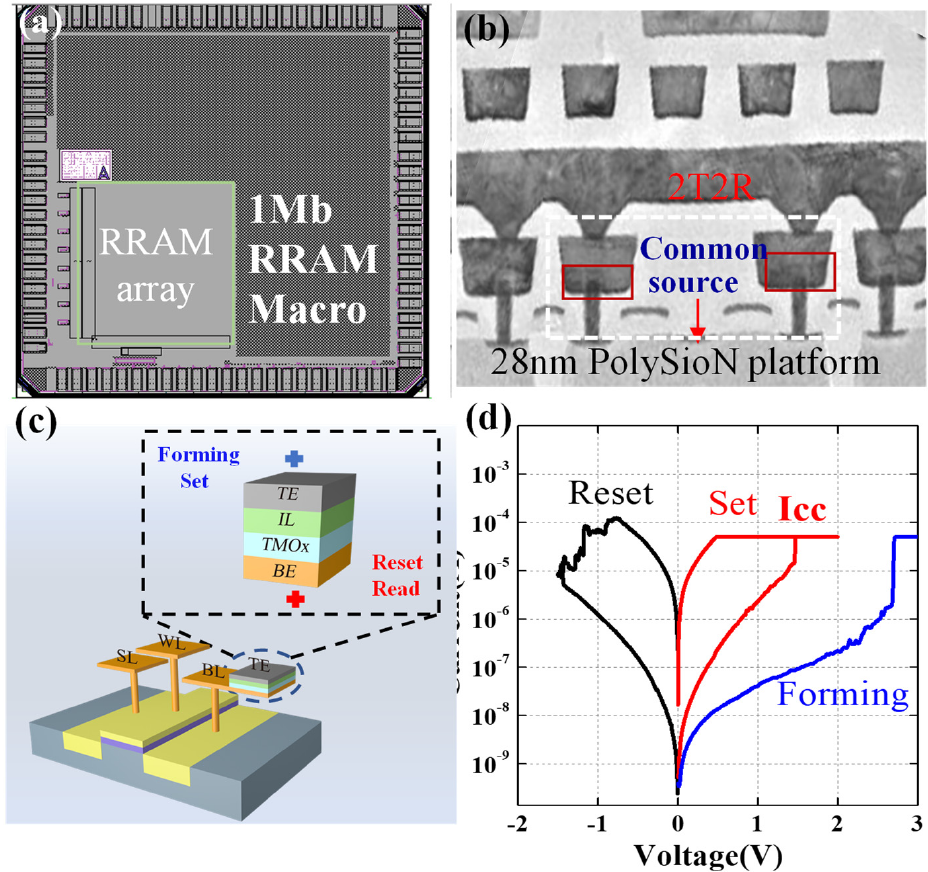
Figure 1. ( a ) Layout of 1Mb embedded RRAM macro. ( b ) Cross-sectional TEM image of RRAM cell. ( c ) Schematic diagram of the operation scheme of a TMOx-based RRAM device in a 1T1R configuration. ( d ) Typical IV curves of oxygen vacancy RRAM.